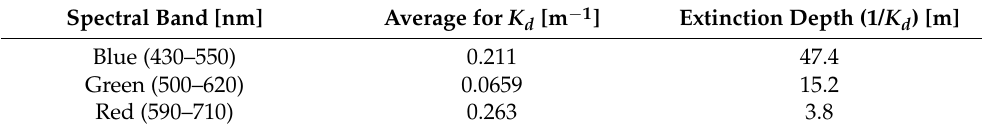
Table 3. Extinction depths for every spectral band of Pleiades-1A in the visible